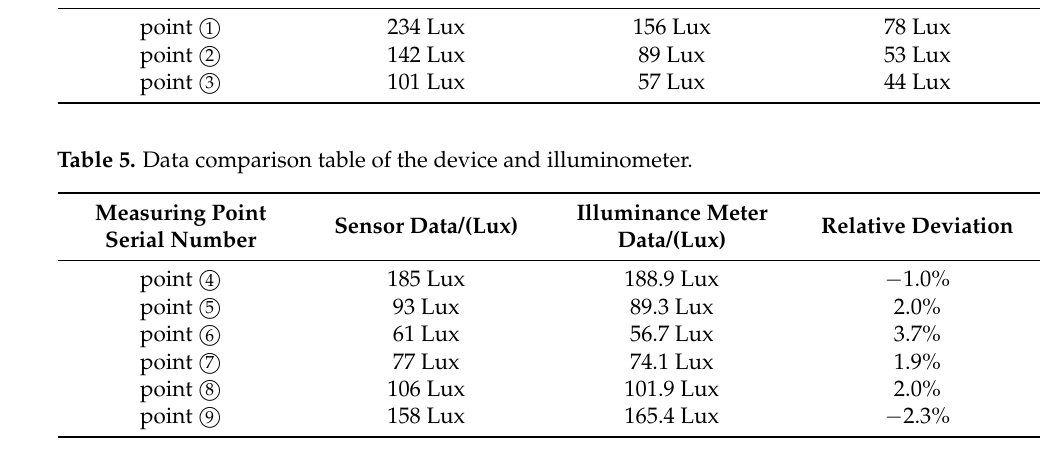
Table 4. Table of comparison between horizontal illumination of vehicle roof and road surface. Measuring Point